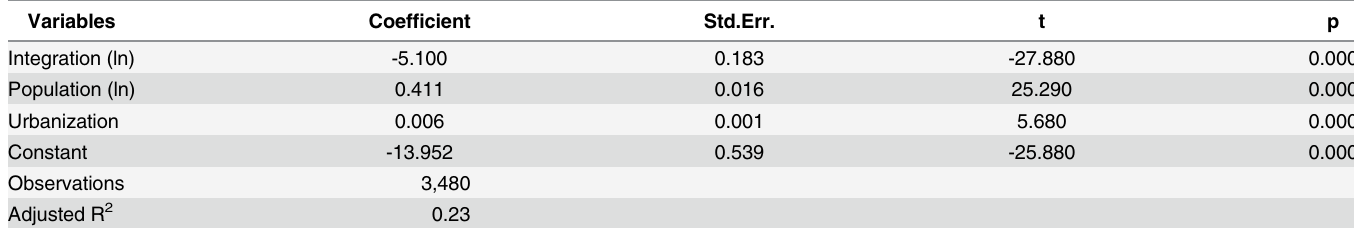
Table 6. Stepwise Regression Results for Countries ’